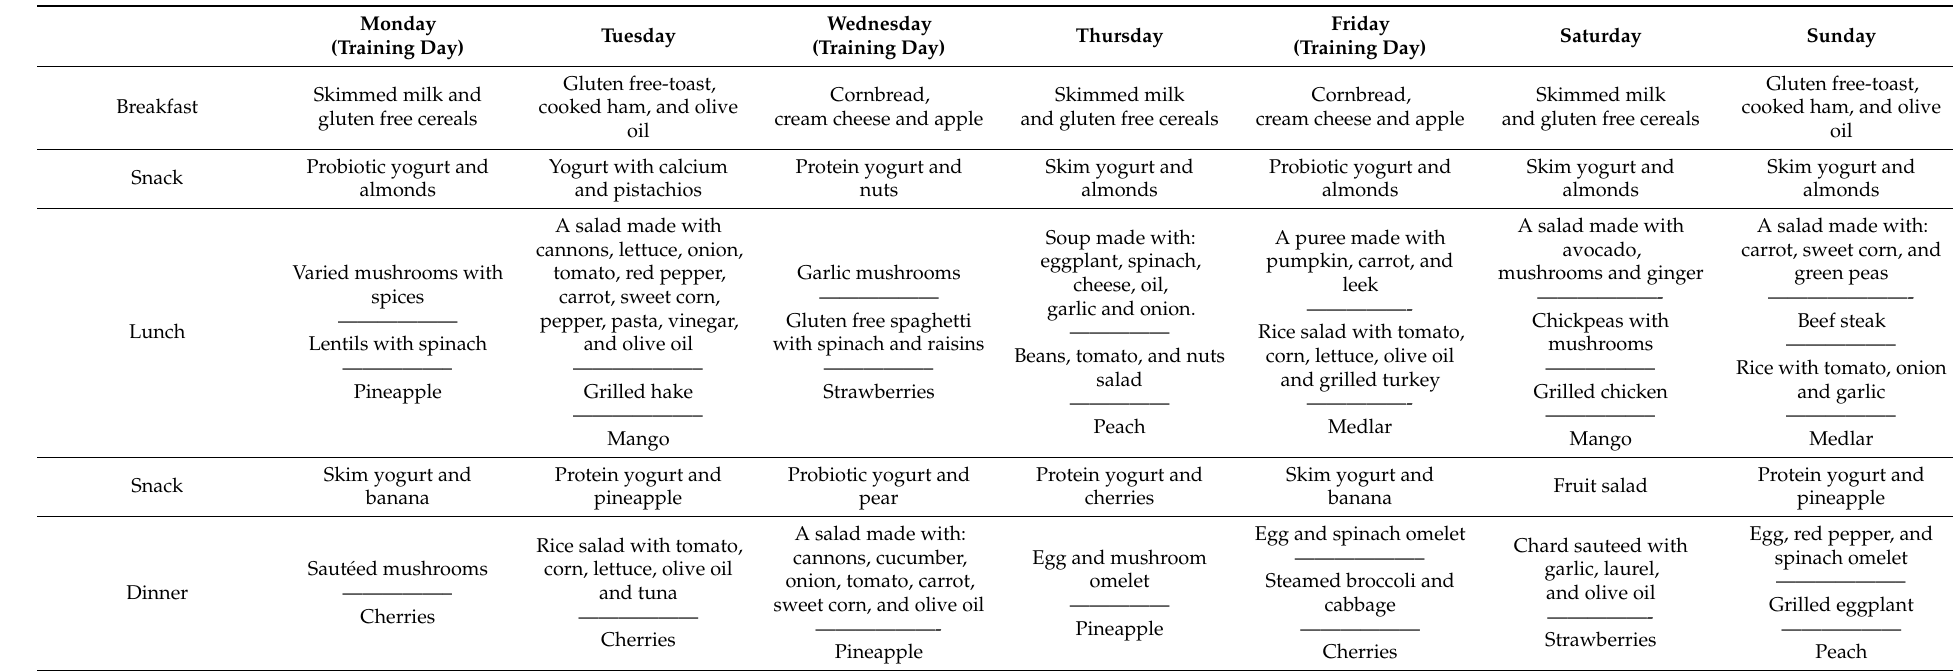
Table 1. Gluten free example